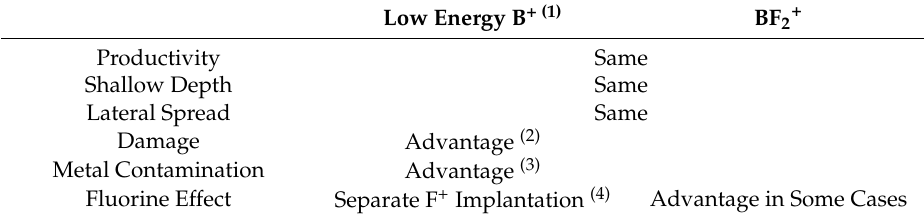
Table 2. Comparison between B + and BF 2+ implantations for forming P + pinning layer at pinned photodiode (PPD). Low Energy B + (1) BF 2+ Same Same Advantage (2) Metal Contamination Advantage (3) Fluorine Effect Separate F + Implantation (4) Advantage in Some